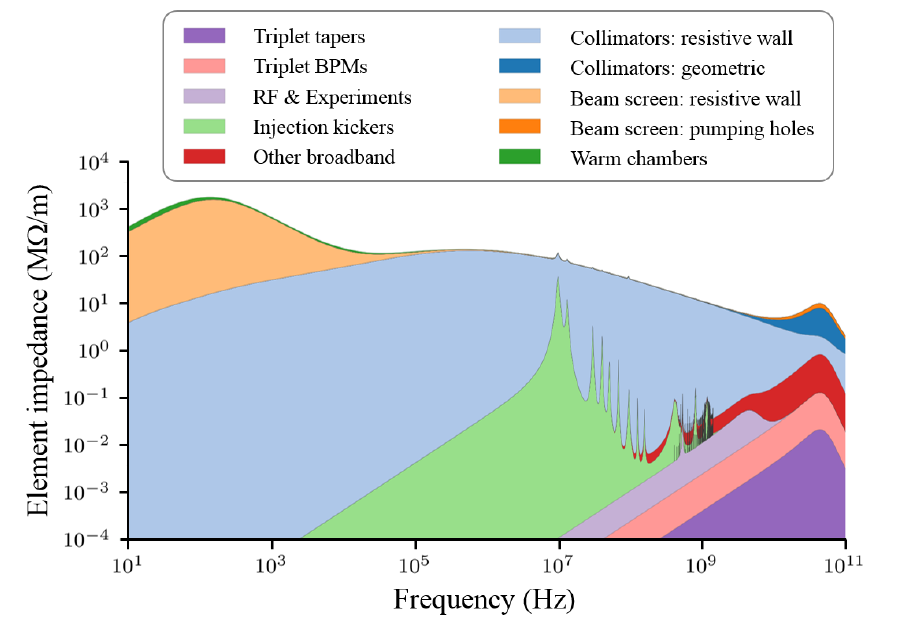
Figure 2. Real part of the horizontal impedance of the LHC at 6.5 TeV for the different elements currently included in the LHC impedance model. The collimator horizontal impedance (shown in light blue) is clearly dominating over a wide range of frequencies. individual components are added on top of one another in the order of the